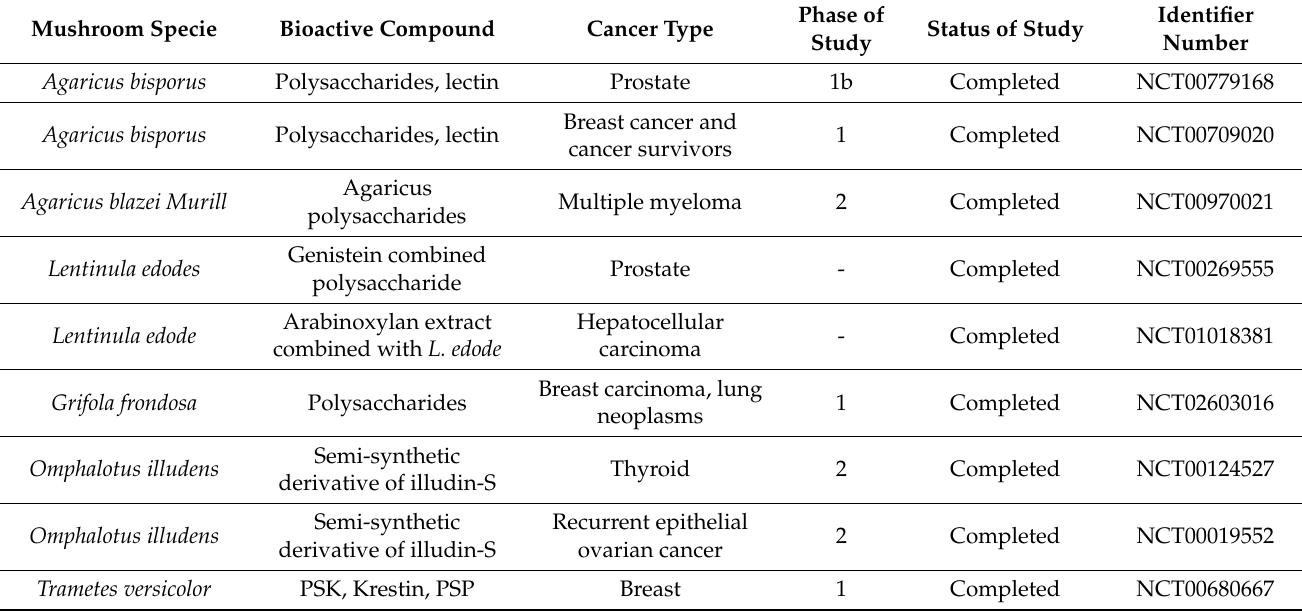
Table 3. List of some significant mushroom species evaluated in clinical trials